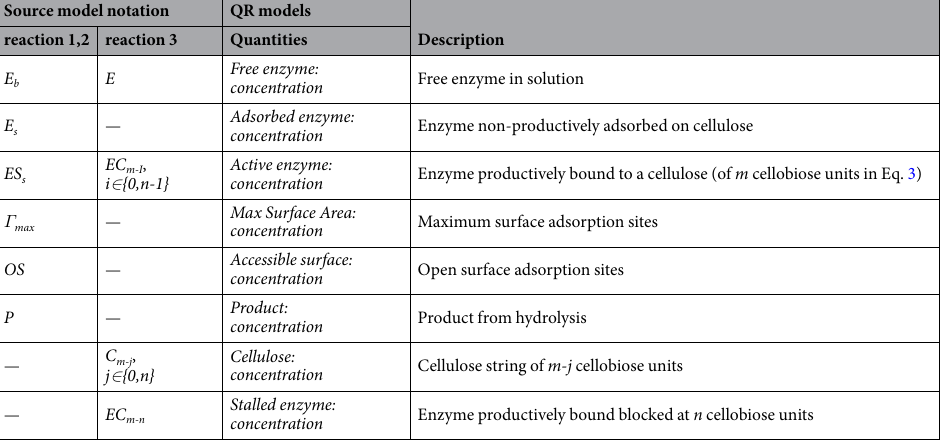
Table 5. Variables used in the source models and their quantity counterparts in the QR